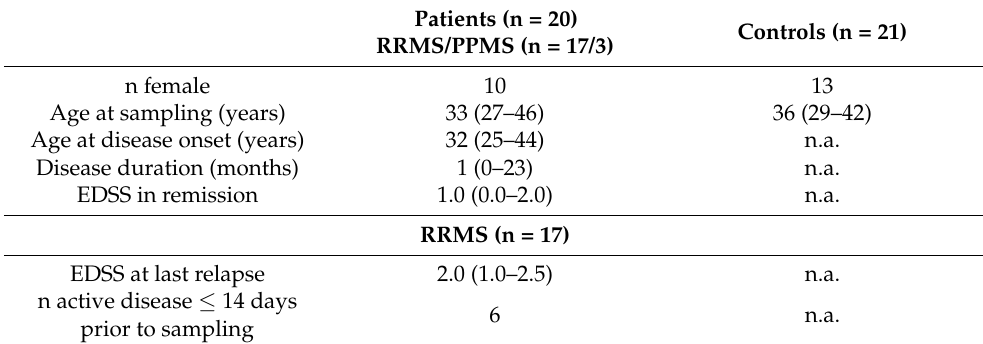
Table 1. Demographic and clinical data of patients and